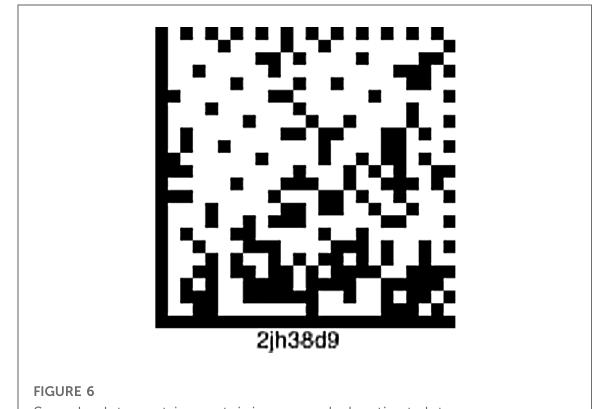
FIGURE 6 Sample data matrix containing encoded patient